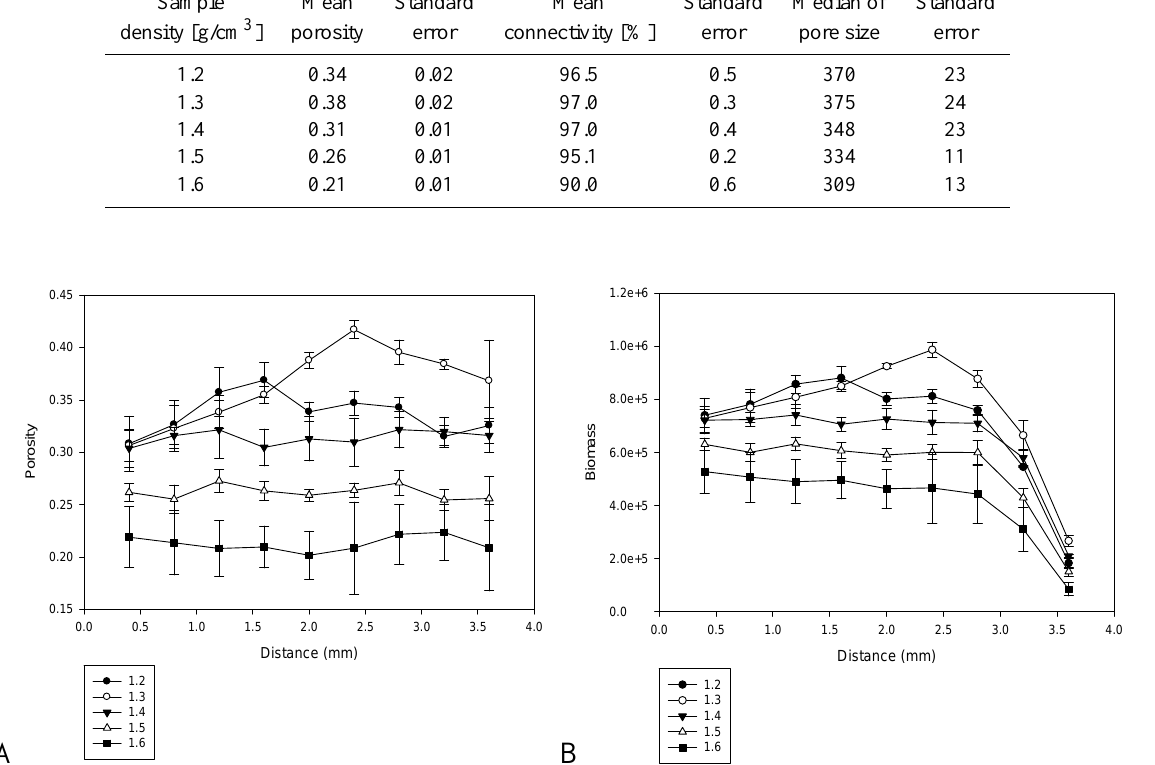
Fig. 3. Mean changes of porosity with distance from the site of inoculation (A) , and the simulated biomass distribution in each segment (B) , for soils at bulk-densities of 1.2, 1.3, 1.4, 1.5, and 1.6g/cm 3